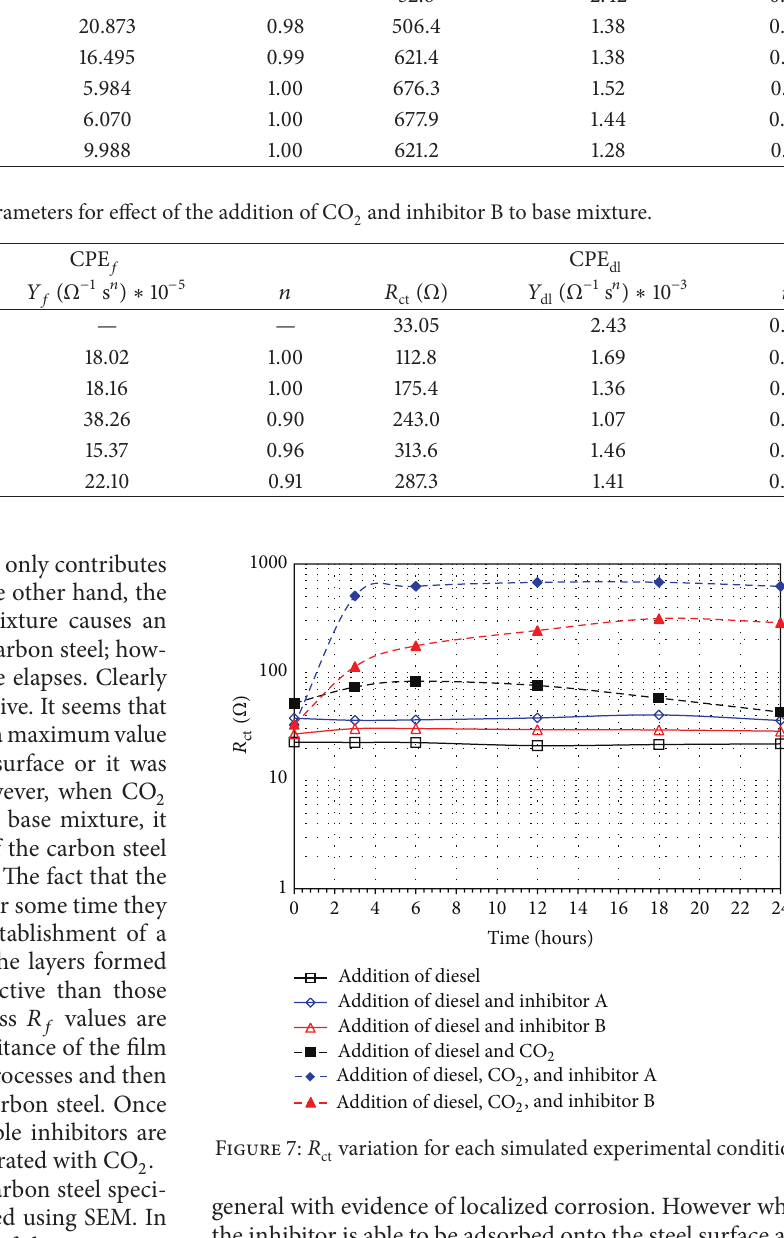
and inhibitor A to base mixture. 2